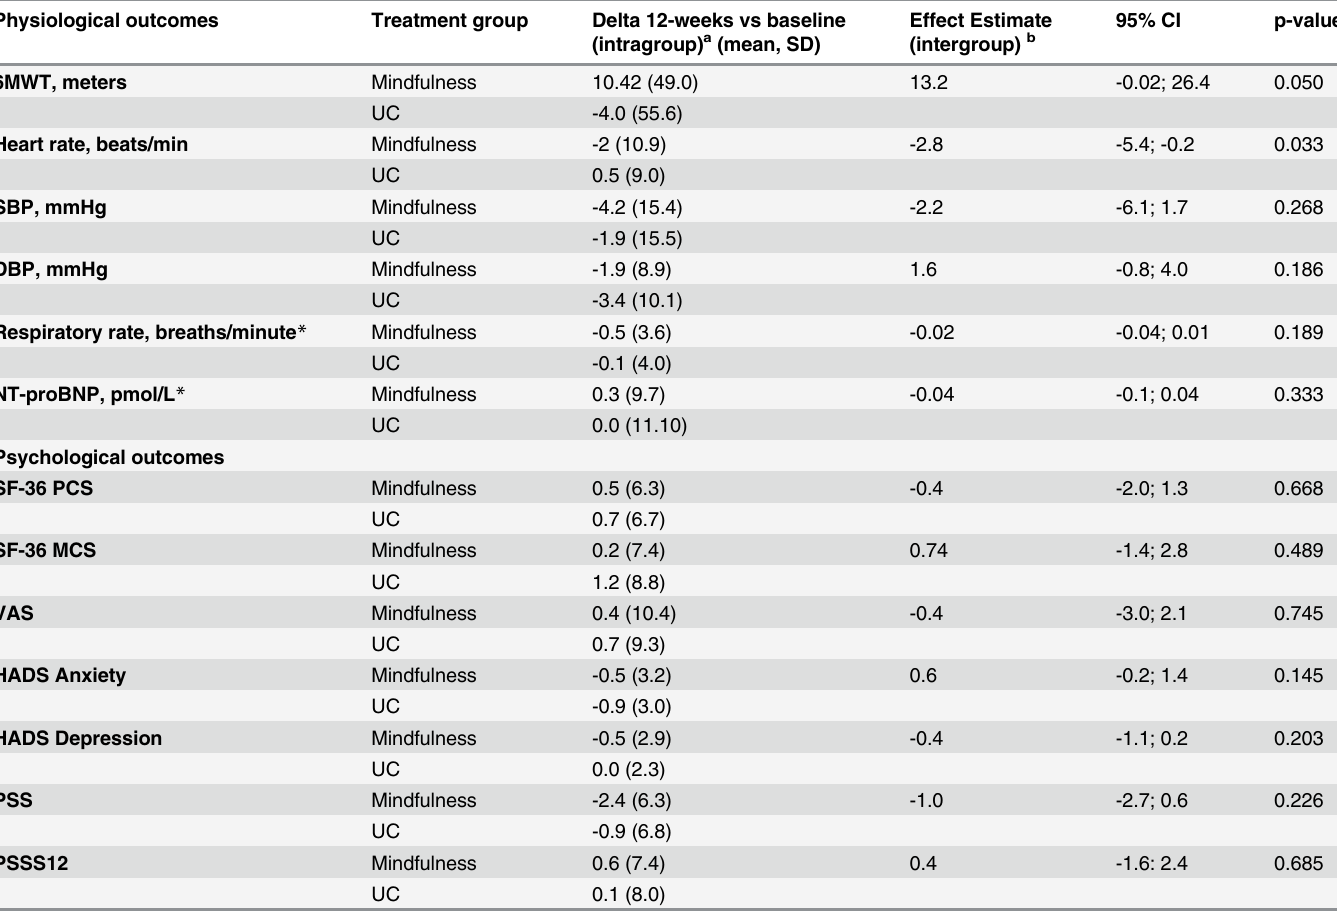
Table 2. Changes in outcomes at 12 weeks compared with baseline (intragroup effect) and differences between treatment groups (difference in delta ’ s, intergroup effect) on physiological and psychological outcomes. Intention-to-treat analyses. Physiological